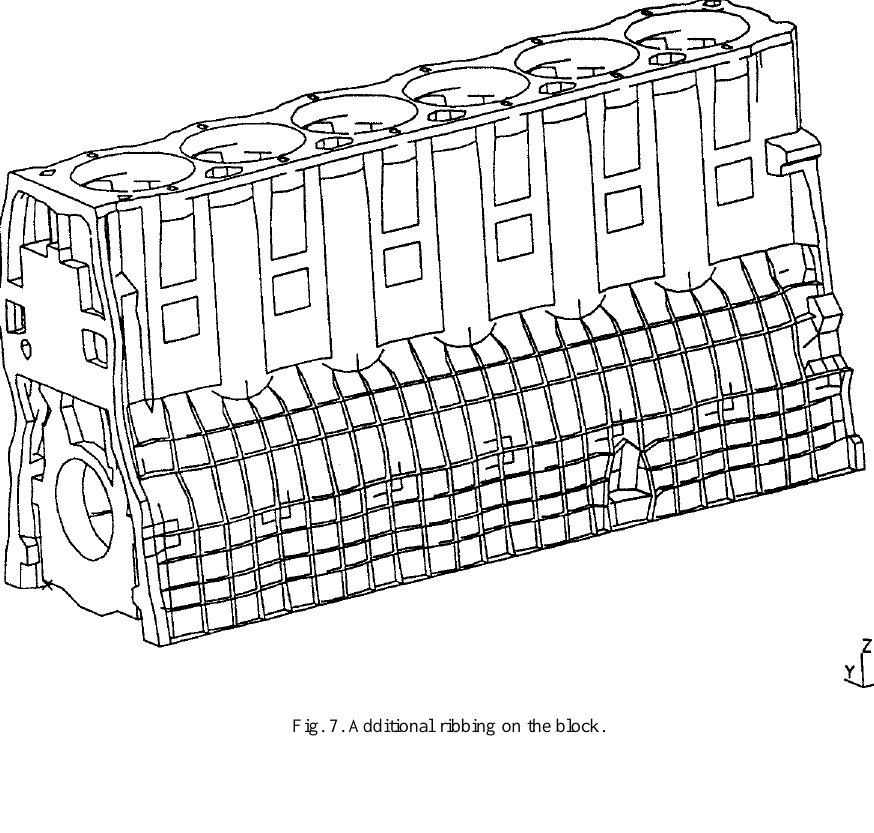
Fig. 7. Additional ribbing on the block.